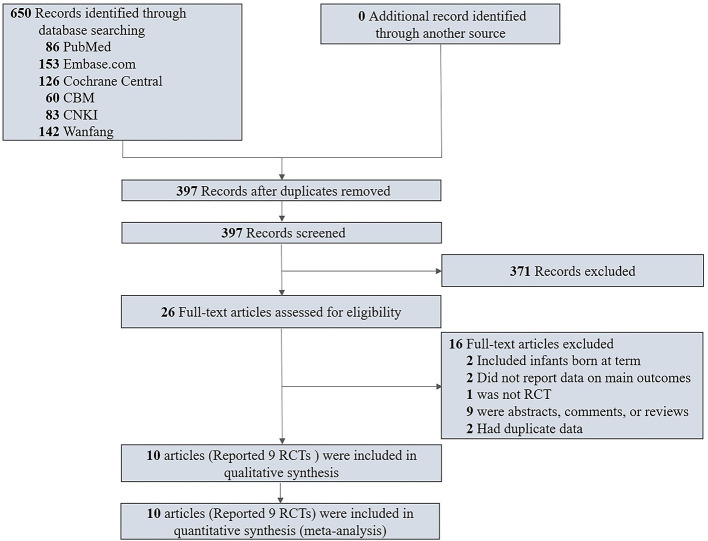
Flow Diagram of Study Selection.